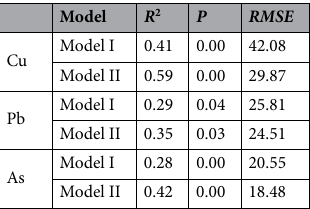
Table 3. Comparison of the linear regression before and after incorporating terrain factors in estimating the heavy metal contents.